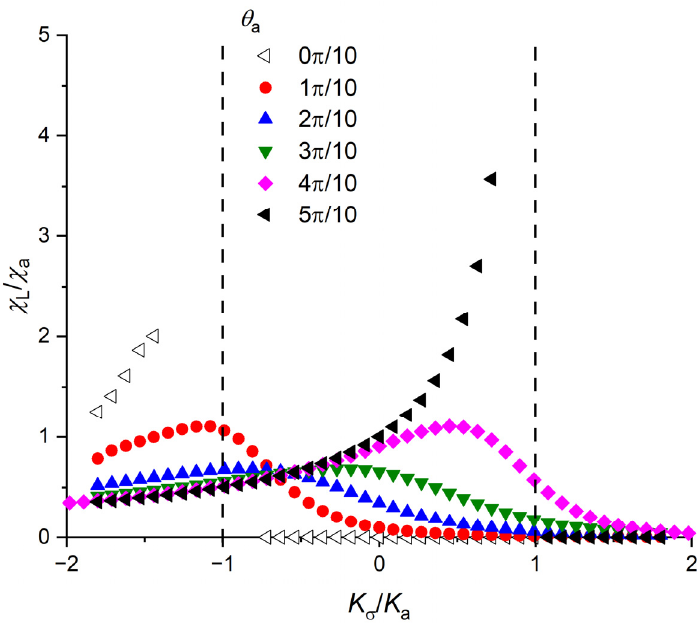
Figure 6. Relative susceptibility components ( χ L / χ a ) versus anisotropy ratio K σ / K a with λ s = 30 ppm,